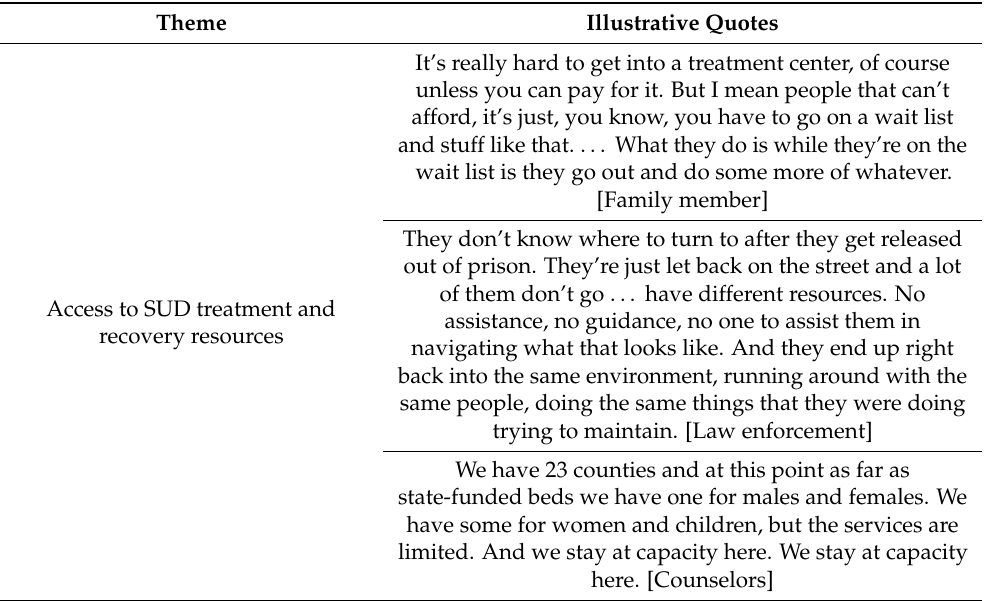
Table A1. Illustrative quotes from the major themes on SUD related needs identified by community